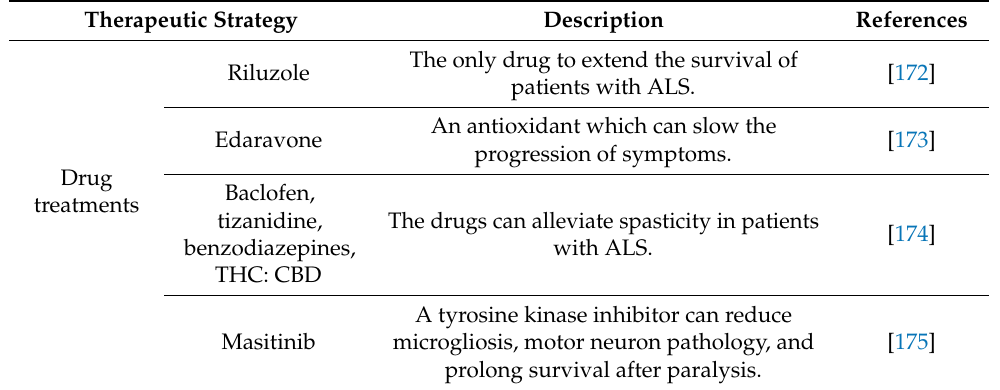
Table 2. Therapeutic strategies of